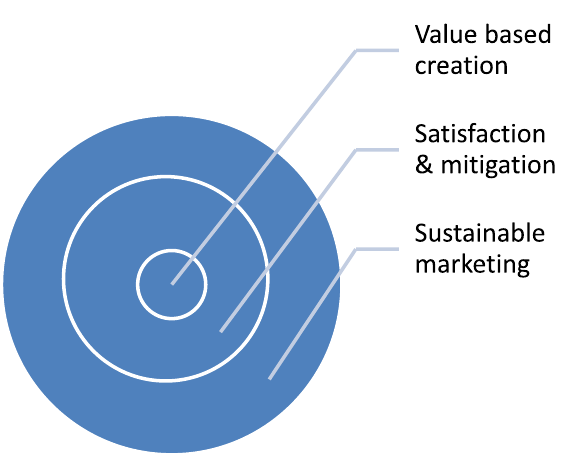
Fig. 3 Proposed Model of Sustainable Marketing: ‘Appendix 1 in Fig. 4 as titled, and shown; “Proposed Model of Sustainable Marketing” emphasizes value creation and core values in propensity towards mitigation and satisfaction in respect to the environment and consumers or customers respectively